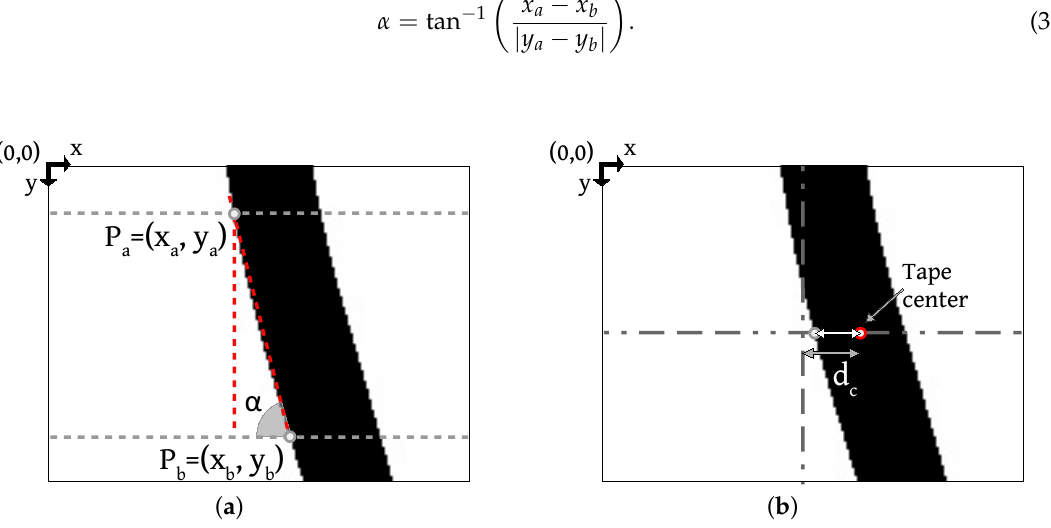
Figure 12. Angle and Distance Measurement. ( a ) the angle between points P a and P b ; ( b ) the distance of the border of the tape from the image center, matching the desired tape